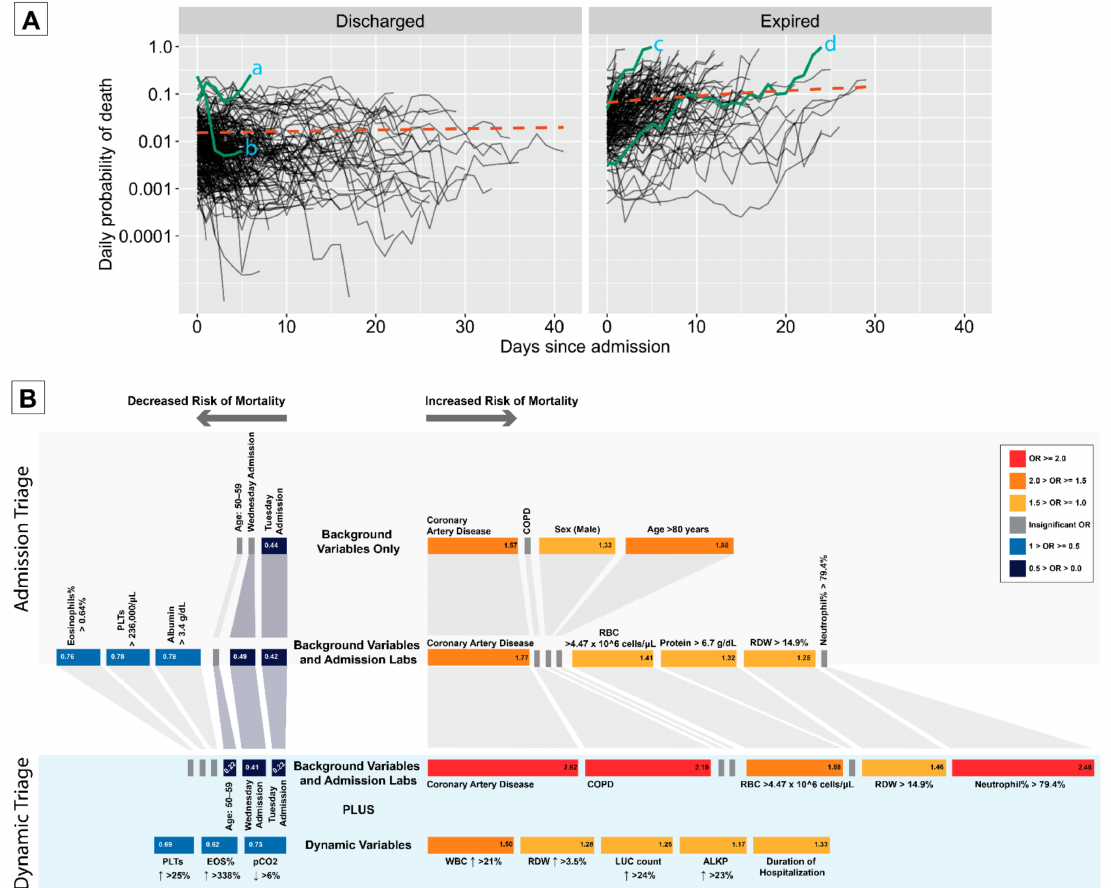
Figure 4. ( A ) Dynamic risk estimates for individual patients: Solid lines represent individual patients from time of admission until either their discharge (left) or death (right). Orange lines represent linear regression lines fitted on the linear scale. Vertical axis represents estimated daily probability of death during hospitalization (log-scale), which were obtained using the posterior median parameter values from the Markov model with post-admission regressors. Individual a was female aged over 80 with a history of hypertension and, generally, throughout the course of her stay was indicated to have a heightened risk of death: she was eventually discharged. Individual b was a male also aged over 80 with no recorded comorbidities: over time, his lab values changed substantially meaning their risk declined precipitously until his discharge. Individual c was female between 70 and 80 years old with a history of hypertension, hyperlipidemia, diabetes and coronary artery disease: over time, her values dramatically worsened, and she died five days after admission. Individual d was male aged between 50 and 60 years old and had end-stage renal disease, hypertension and diabetes: while his test values upon admission suggested low mortality risk, over time, his values worsened, and he died after more than 20 days in hospital. ( B ) Clinical decision tool for hospitalized COVID-19 patients: Each row of the diagram illustrates the key variables most useful for patient risk stratification based on the levels of available information. The block sizes, color and numbers within blocks represent odds ratios representing risk of daily mortality. The lab values indicate the cutoff point and direction of change associated with the given odds